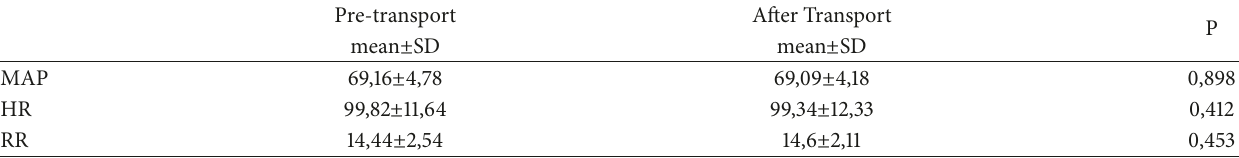
Table 1: Vital signs of all patients (MAP: mean arterial pressure, HR: heart rate; RR: respiratory rate). Pre-transport